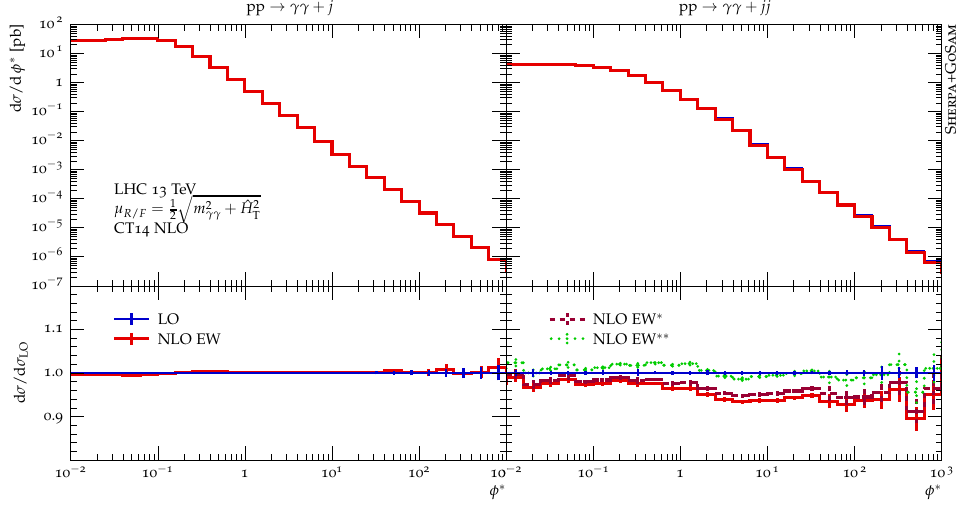
Figure 9 . (cid:30) (cid:3) of the leading and subleading isolated photon system in (cid:13)(cid:13) + 1 ; 2 jets production at 13 TeV at the